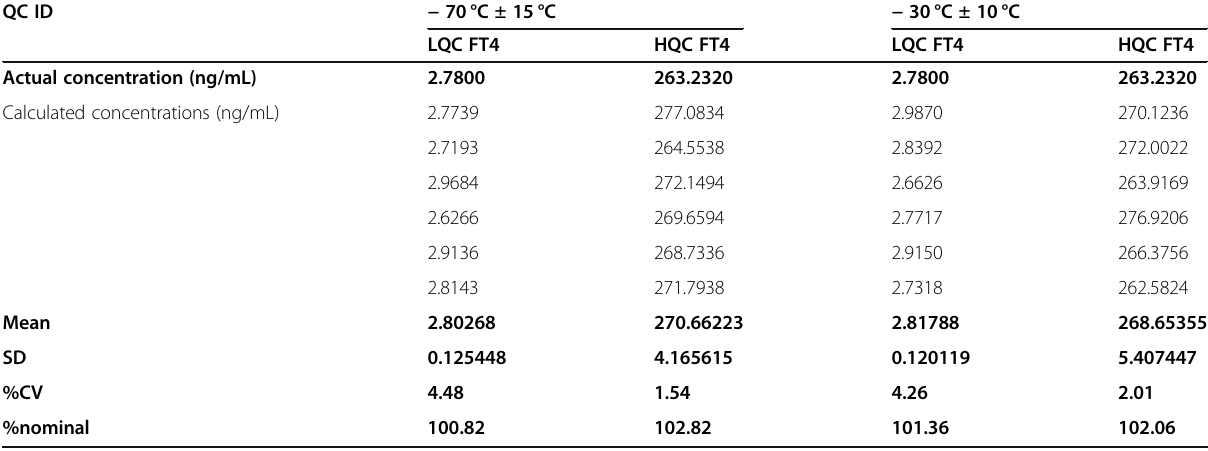
Table 13 Freeze-thaw stability for bexarotene (at − 70 °C ± 15 °C and − 30 °C ± 10)